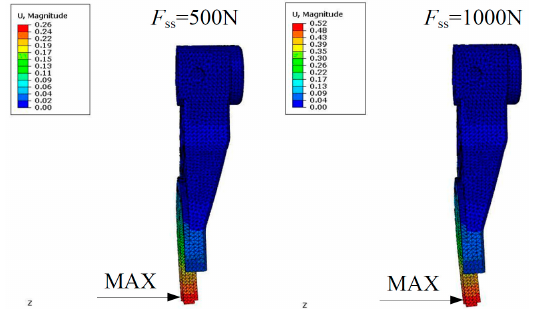
Figure 8. Analysis results of the shift fork deformation.